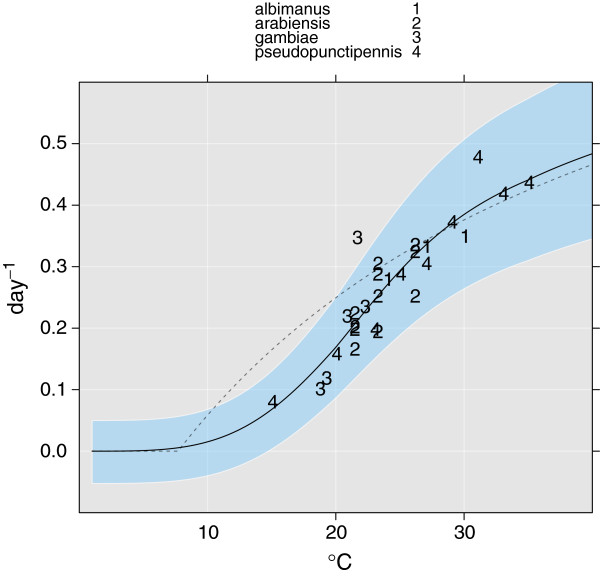
Inverse of the duration of the gonotropic cycle according to the mean daily temperature (in °C). The solid black line shows Eq. 26 and the dashed line shows the formula given by Hoshen and Morse [108].